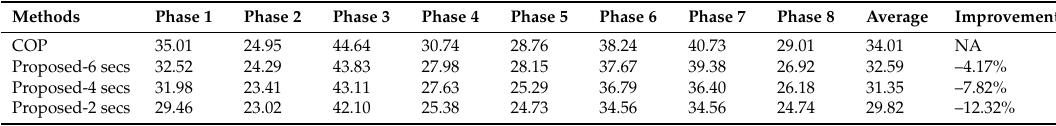
Table 3. The average vehicle delay of each phase (volume level is 3500 veh/h). Methods